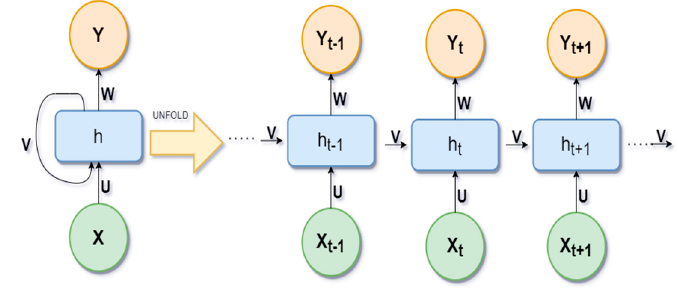
Figure 3. Unfolding RNN architecture.